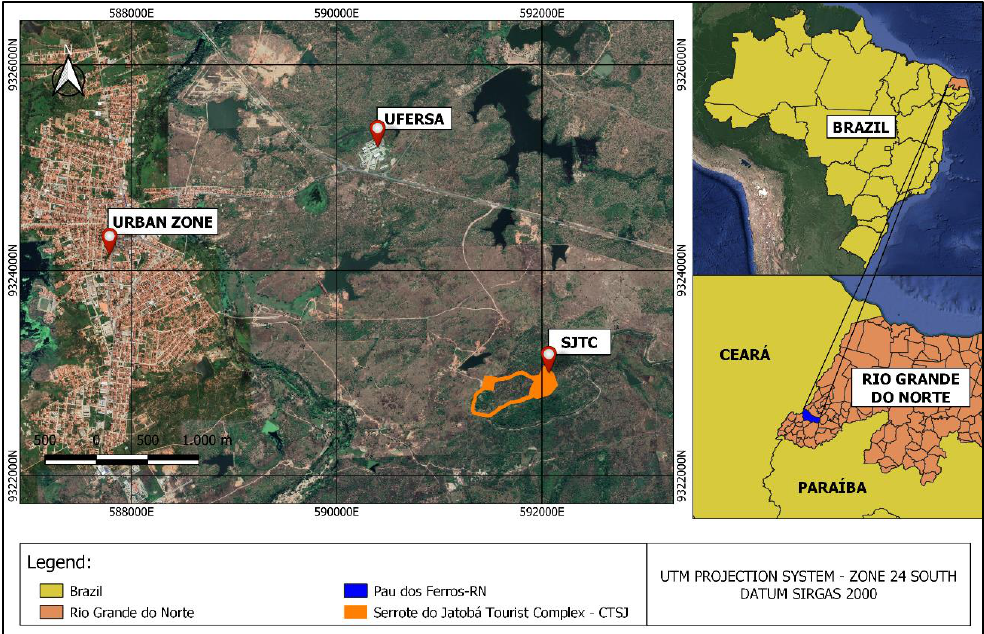
Figure 2. Location map of Pau dos Ferros-RN and the Serrote do Jatobá Tourist Complex (CTSJ).